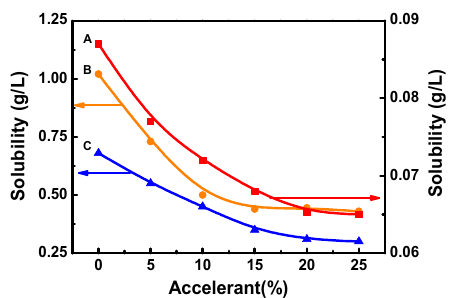
Figure 4. The solubility of three disperse dyes in the D5 solvent (A: C. I. Disperse Red 177, B: C. I. Disperse Orange 30, and C: C. I. Disperse Blue 367).